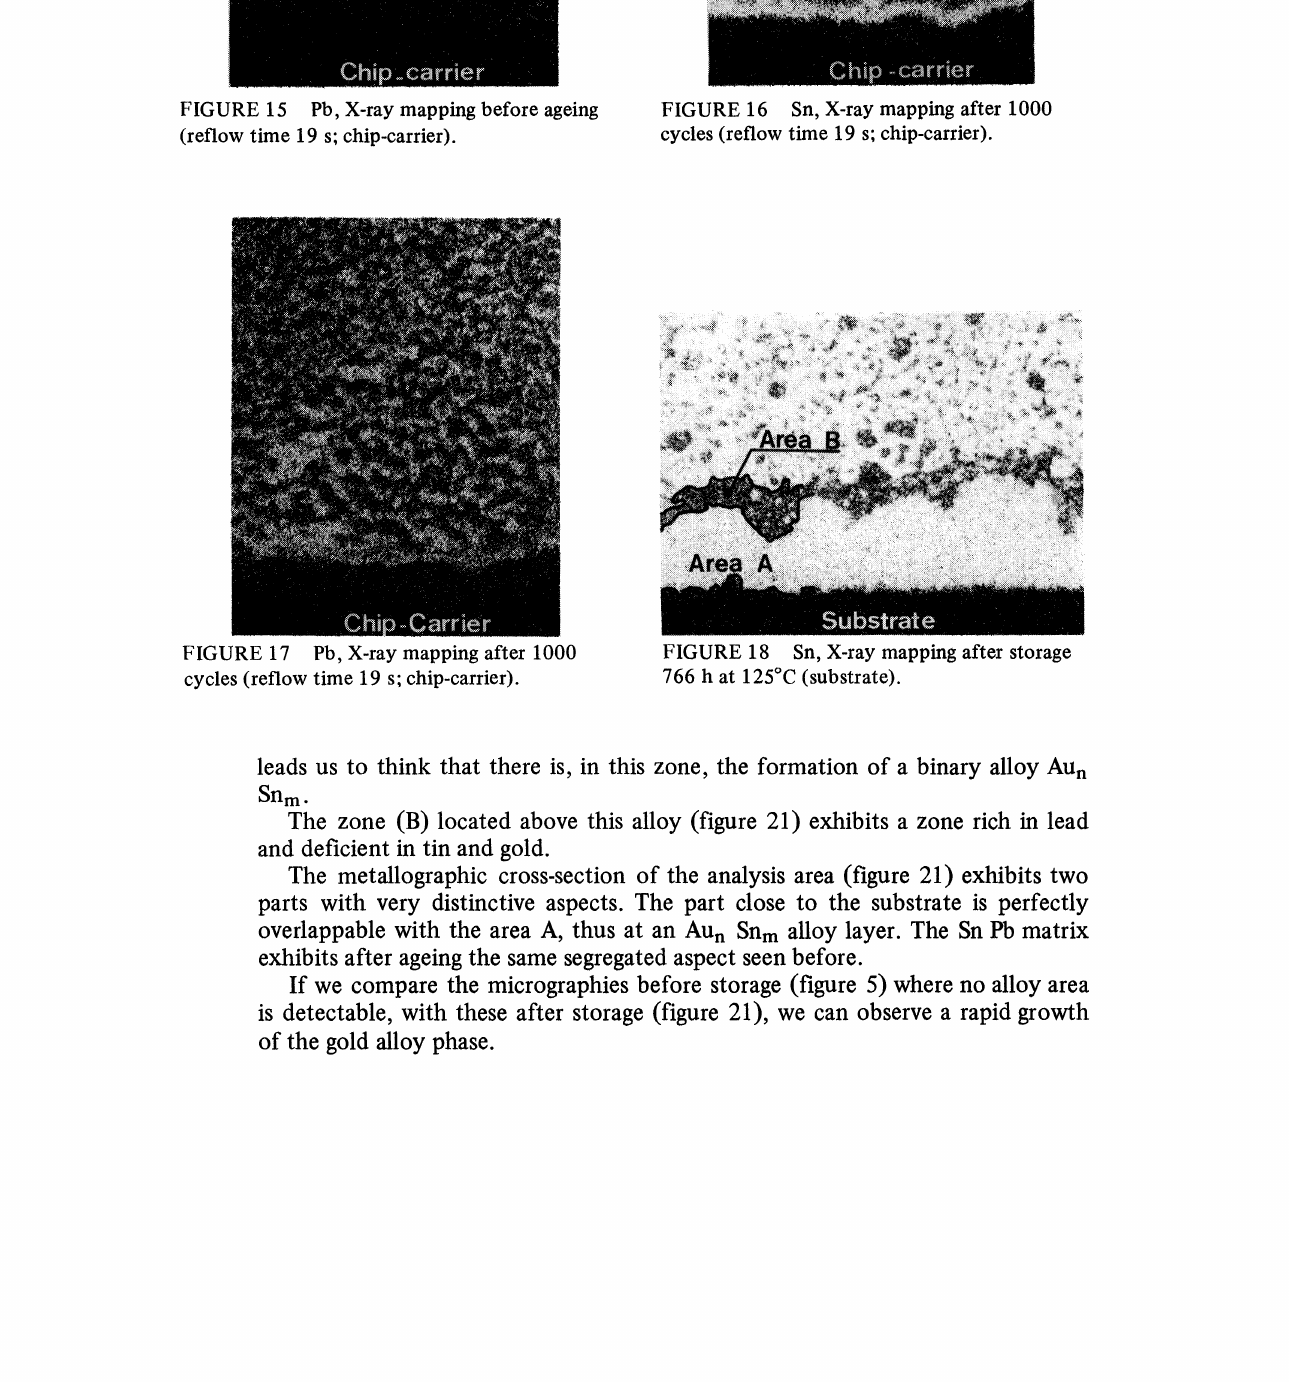
FIGURE 16 Sn, X-ray mapping after 1000 cycles (reflow time 19 s; chip-carrier).